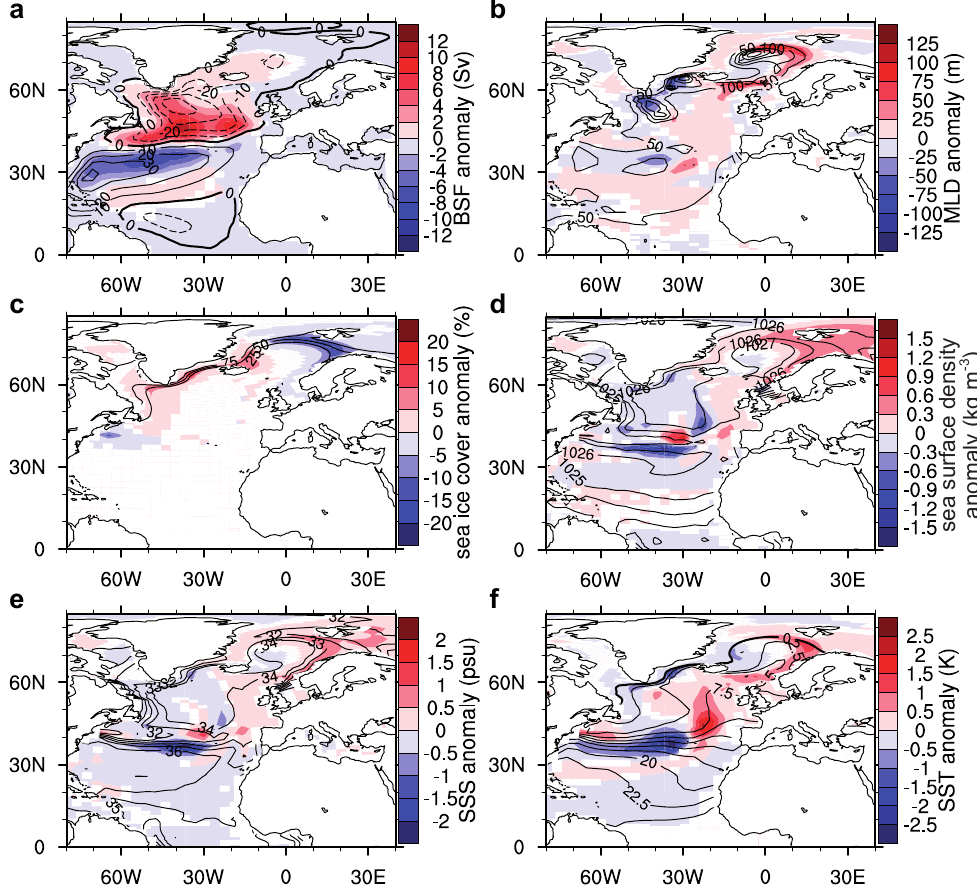
Fig. 7. The difference of the weak and strong AMOC periods (colors) and the mean state for the weak AMOC (black contour lines) in the North Atlantic region averaged over all Type 3 transitions: (a) barotropic stream function (BSF), (b) mixed layer depth (MLD), (c) sea ice cover, (d) sea surface density, (e) sea surface salinity (SSS), and (f) sea surface temperature (SST). For the difference patterns only the areas are colored that are significant at the 5% level based on the two-sided Student’s t-test. For the contour lines the intervals are 10Sv (BSF), 50m (MLD), 25% (sea ice cover), 1kgm − 3 (sea surface density), 1 psu (SSS), and 2.5K (SST),